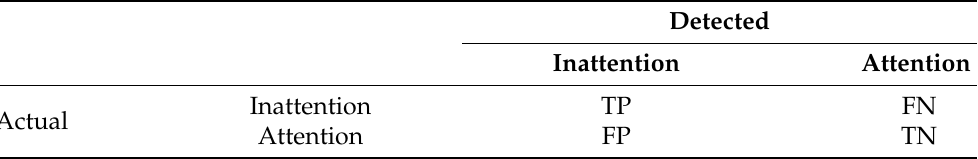
Table 2. Confusion matrix for inattention detection, where TP, FN, FP, and TN indicate true positive, false negative, false positive, and true negative,